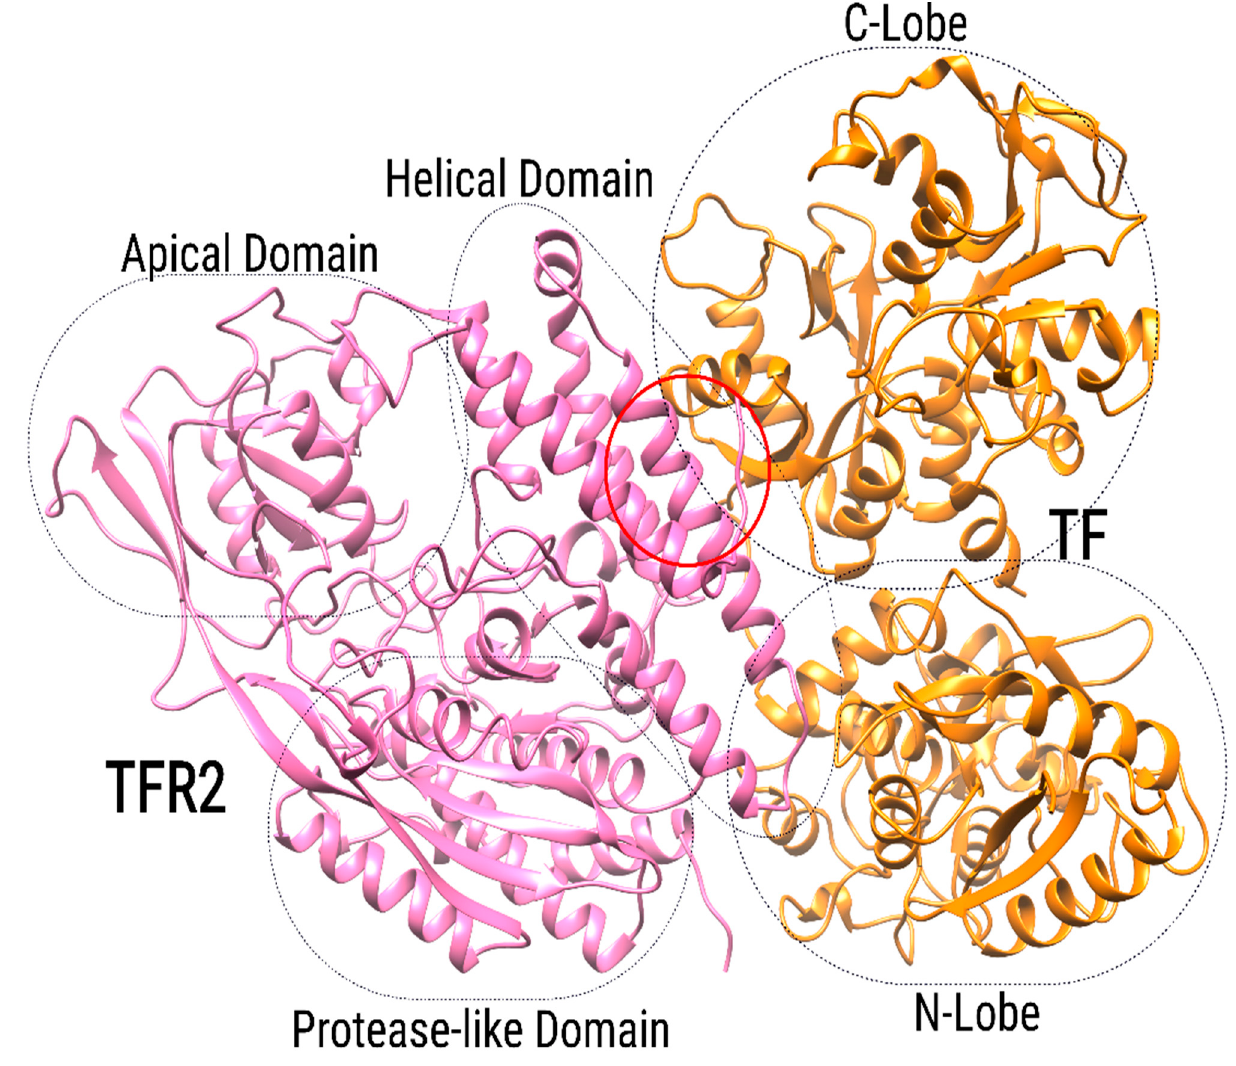
Figure A3. Global view of the binding mode between TFR2 (pink) and TF (orange) proteins. Black dots encircle all domains, and their corresponding names are indicated. The region where TFR2 position 680 is located is shown with a red circle.